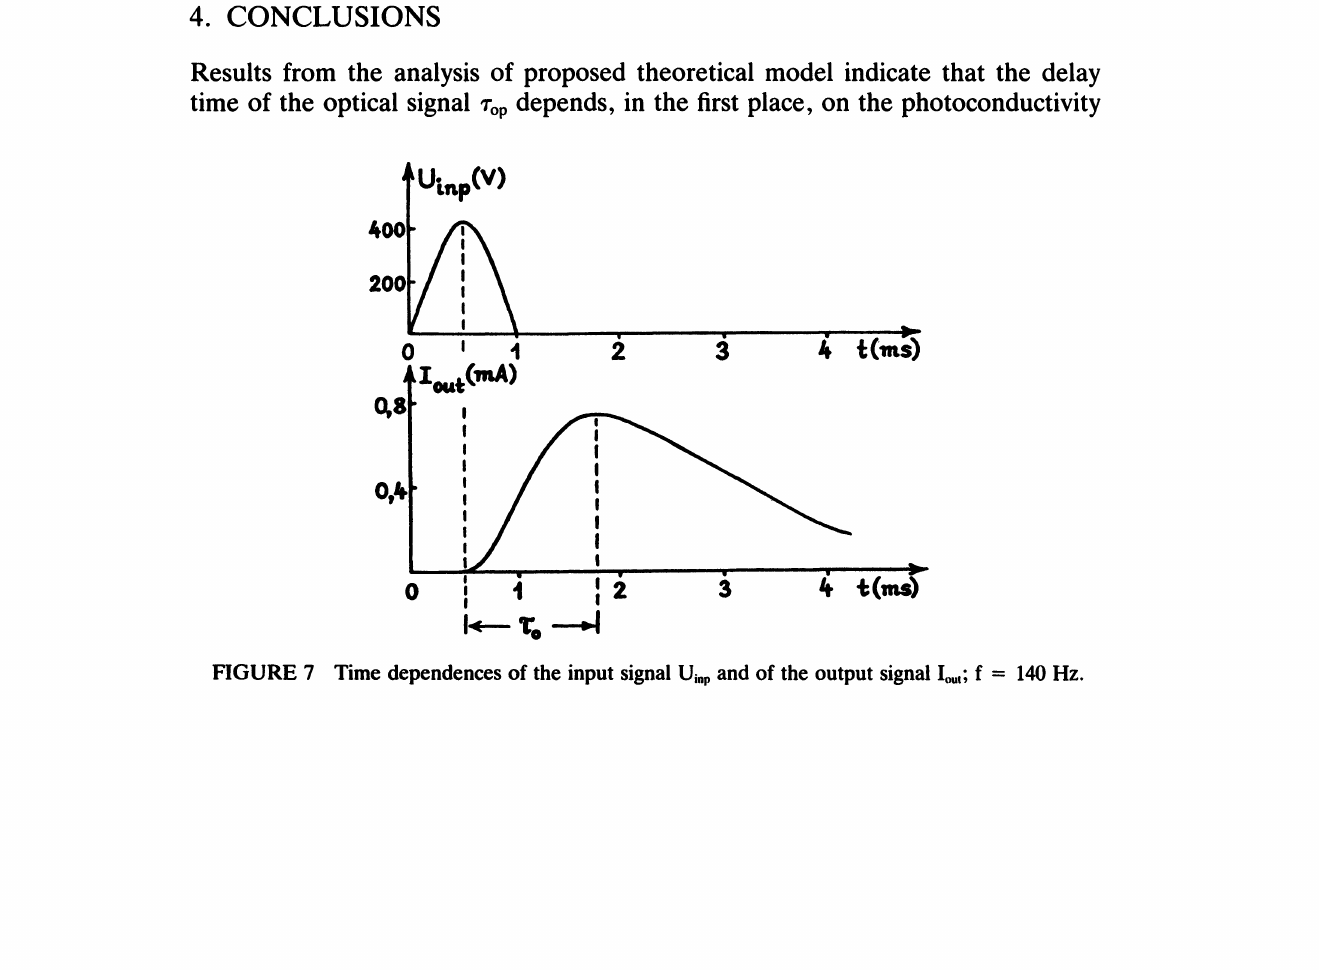
FIGURE 7 Time dependences of the input signal Uin and of the output signal Io.t; f 140